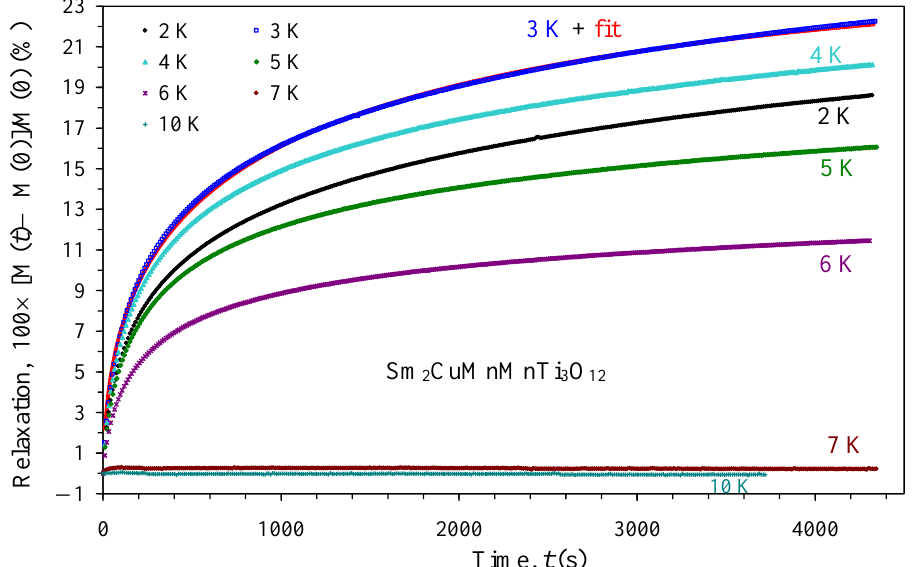
Figure 8. Relaxation curves defined as 100 × [M( t ) − M(0)]/M(0) versus time ( t ) for Sm 2 CuMn(MnTi 3 )O 12 at temperatures of 2, 3, 4, 5, 6, 7, and 10 K. Experimental points are given by symbols, and the red line shows the fit at 3 K as an example. The equation used for fitting and the resultant parameters are listed in Table 3. Table 3. Results of the fittings of the relaxation curves of Sm 2 CuMn(MnTi 3 )O 12 at different temper- atures.